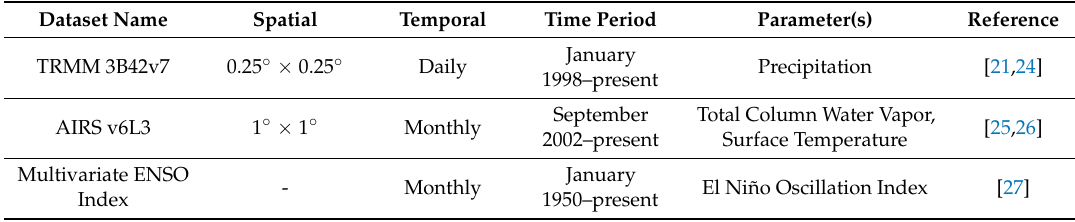
Table 1. Sources of data used in this study.